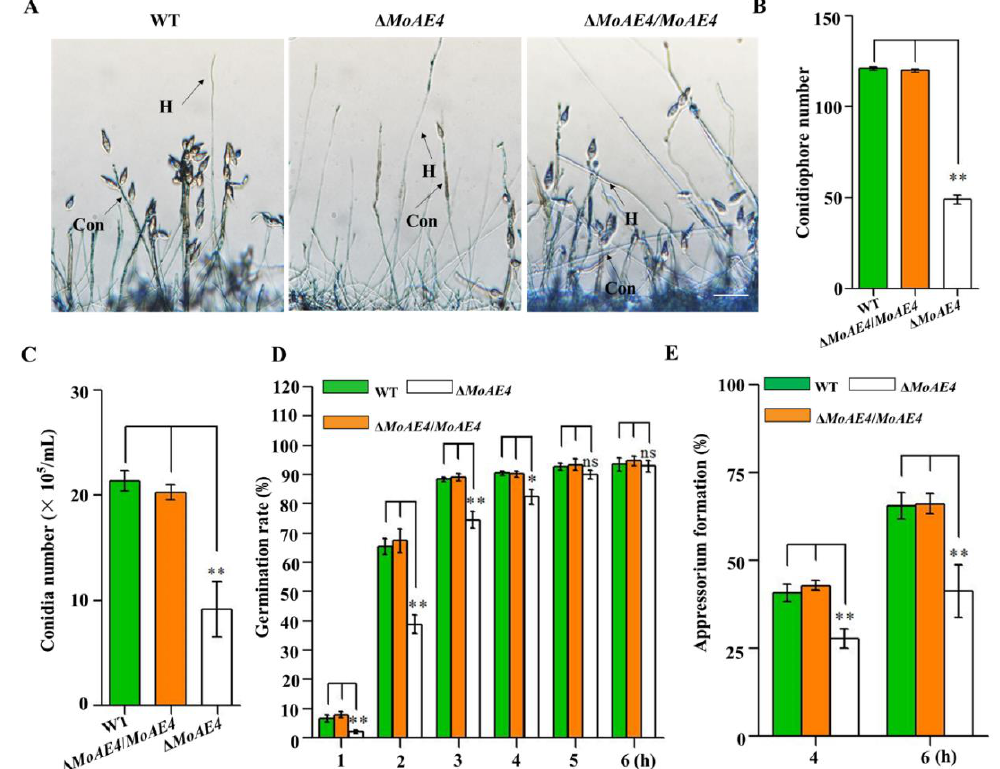
Figure 5. Conidium and appressorium development analysis of the wild type and created strains. ( A ) Conidiophores stained with lactophenol cotton blue. The conidiophores of the wild type, the Δ MoAE4 and Δ MoAE4 / MoAE4 strains induced for 48 h were stained with lactophenol cotton blue, and observed and counted under a light microscope at room temperature. The hyphae are stained blue, whereas the conidiophore stalks are in gray. Bar = 50 μm. Con, conidiophores; H, hyphae. ( B ) Statistical analysis of the conidiophores number of the wild type, the Δ MoAE4 and Δ MoAE4 / MoAE4 mutant strains. ( C ) Statistical analysis of conidial production in the strains . The conidia were harvested from the 3-day-old mycelium grown on OMA media, and counted using a hemocytometer for all the three strains. ( D ) Conidial germination rate. Conidial germination was measured on a hydrophobic cover slips and was calculated under the microscope at 1, 2, 3, 4, 5, and 6 h post inoculation. ( E ) Appressorial formation rate. Appressorial formation was measured on a hydrophobic cover slips and was calculated under the microscope at 4 and 6 h per inoculation. The analysis was performed using an independent samples t -test. ns p > 0.05. * p < 0.05. ** p < 0.01. Error bars indicate the mean ± SD from three independent experiments.